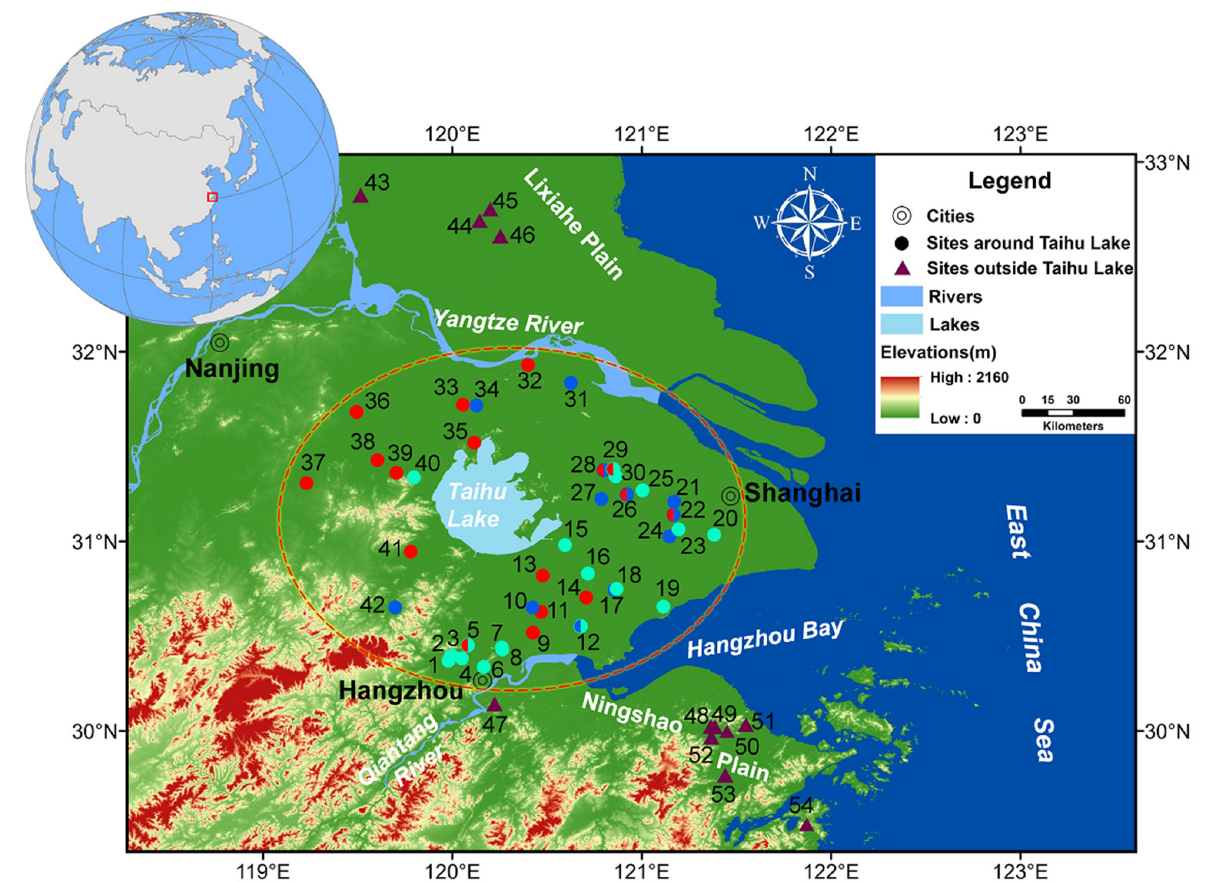
Figure 1. Location of the area around Taihu Lake and the distribution of Neolithic archaeological sites involved in this study: (1) Bianjiashan; (2) Mojiaoshan; (3) Meirendi; (4) Maoanli; (5) Nanzhuangqiao; (6) Shuitianfan; (7) Yujiashan; (8) Maoshan; (9) Xinqiao; (10) Dongjiaqiao; (11) Luojiajiao; (12) Xiaodouli; (13) Guangfucun; (14) Majiabang; (15) Longnan; (16) Shuangqiao; (17) Nanhebang; (18) Dafen; (19) Zhuangqiaofen; (20) Maqiao; (21) Fuquanshan; (22) Songze; (23) Guangfulin; (24) Yaojiaquan; (25) Shaoqingshan; (26) Jiangli; (27) Chenghu; (28) Caoxieshan; (29) Chuodun; (30) Zhumucun; (31) Xujiawan; (32) Dongshancun; (33) Xudun; (34) Qingchengdun; (35) Yangjia; (36) Sanxingcun; (37) Shendun; (38) Xixi; (39) Luotuodun; (40) Xiawan; (41) Jiangjiashan; (42) Yaodun; (43) Longqiuzhuang; (44) Kaizhuang; (45) Jiangzhuang; (46) Qingdun; (47) Kuahuqiao; (48) Jingtoushan; (49) Tianluoshan; (50) Cihu; (51) Yushan; (52) Hemudu; (53) Xiawangdu; (54) Tashan. Red dots—sites of Majiabang Culture; dark blue dots—sites of Songze Culture; light blue dots—sites of Liangzhu Culture; dots with two colors indicate that the site has two corresponding cultural attributes.